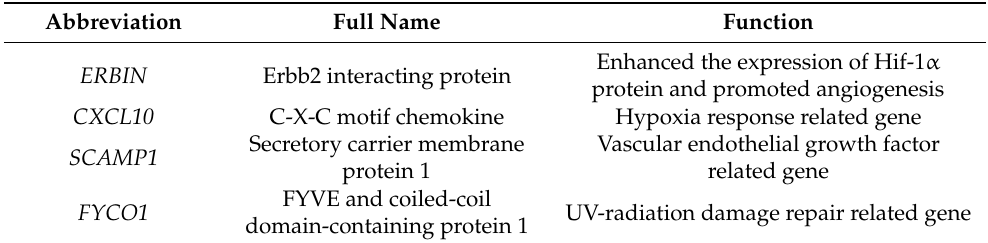
Table 1. Basic information on four genes associated with high-altitude adaptation mechanisms that exhibit convergent positive selection